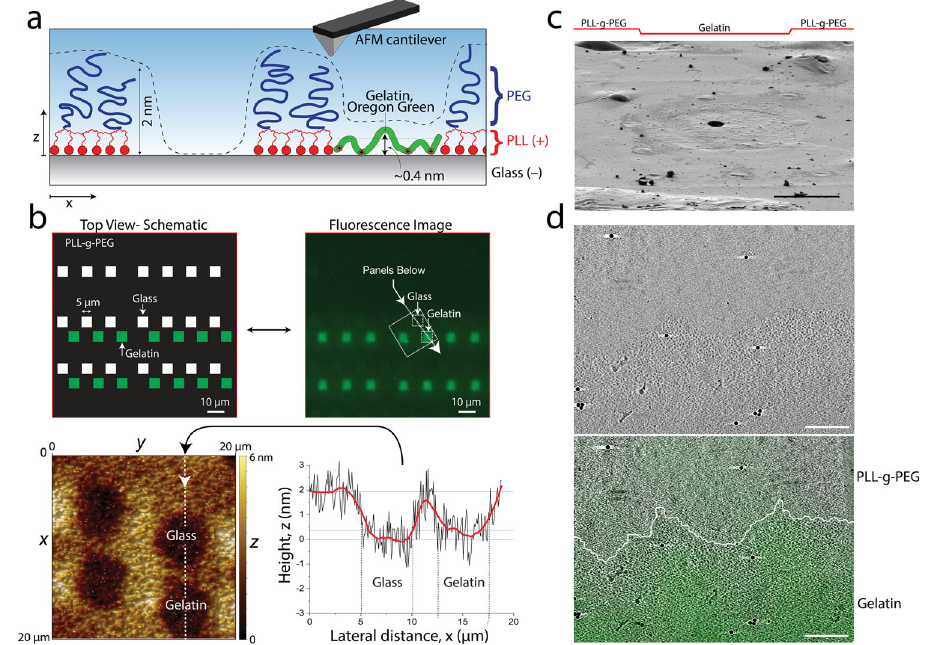
Fig. 2 | Nanoscale characterization of the micropatterning of holey carbon EM grids using photomolecular adsorption. a Schematic of an AFM cantilever scanning the surface of adsorbed gelatin surrounded by PLL-g-PEG. b A 2-step digital mask photopatterning method was used to create 5 µ m squares with and without protein (upper panels). AFM probe scans clearly show squares with and without protein, which could be quanti fi ed with 0.5nm resolution (lower panels). Representative images from triplicate measurements. c Custom ECM (Oregon greengelatin)45 µ m×45 µ msquarepatternsurroundedbyPLL-g-PEGontheholey